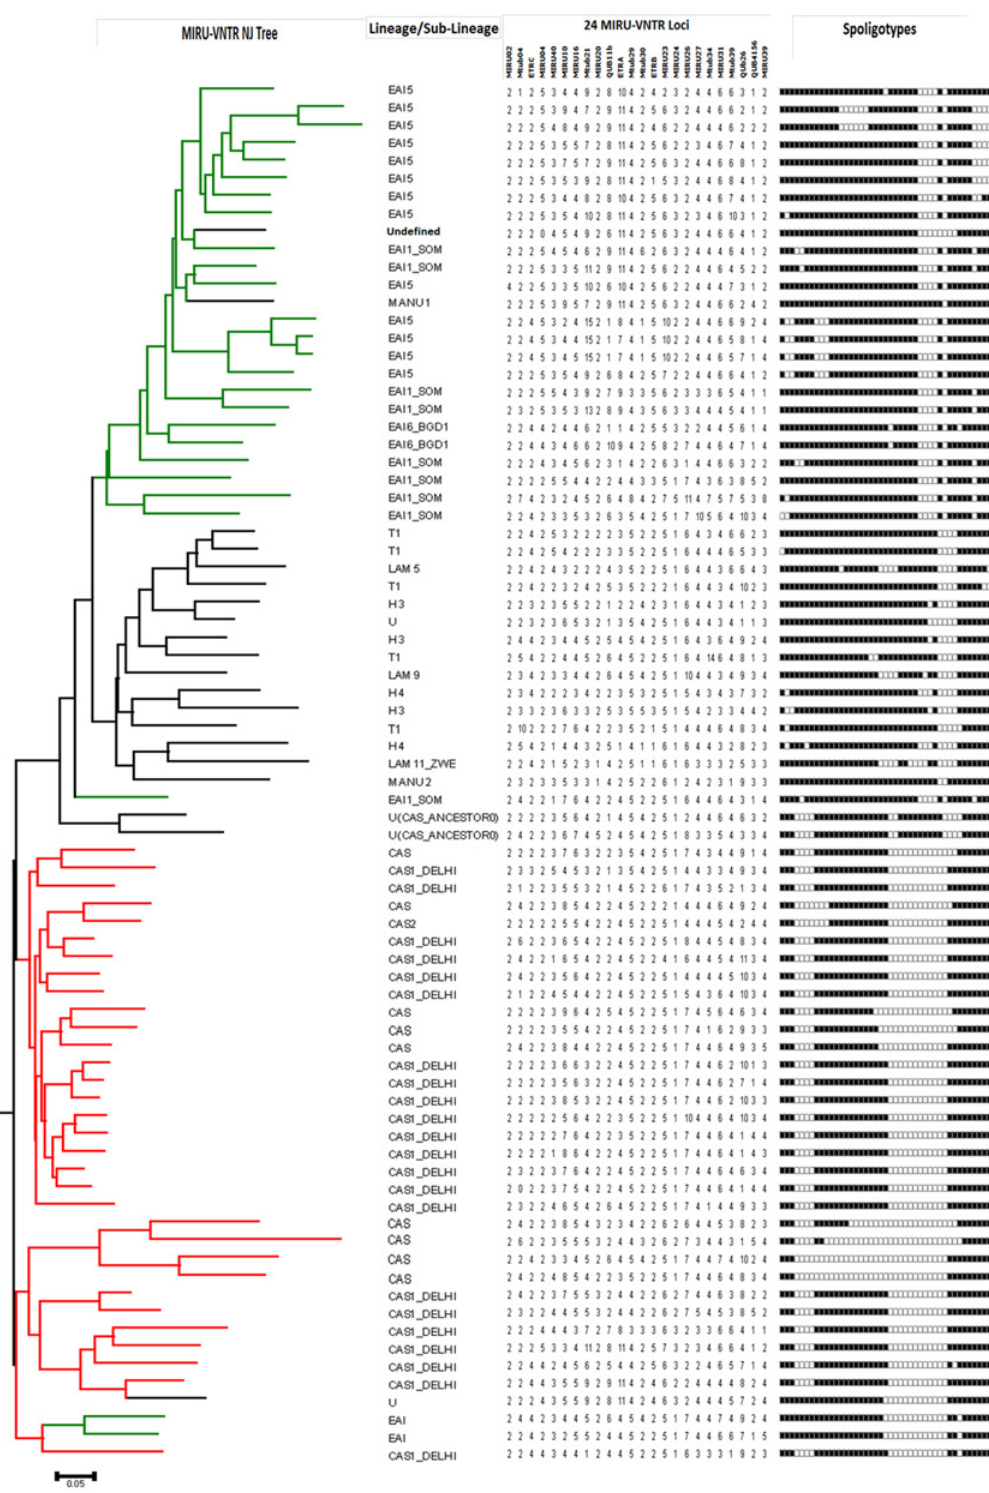
Fig 4. Genotypic diversity of 78 Non-Beijing and Non-orphan MTBC isolates from Assam. A MIRU-VNTR based dendrogram was generated using NJ tree analysis. M . tuberculosis strain lineages were identified using MIRU-VNTR plus identification database. 24-loci MIRU-VNTR alleles and spoligotypes from 78 isolates are also represented along with MIRU-VNTR NJ